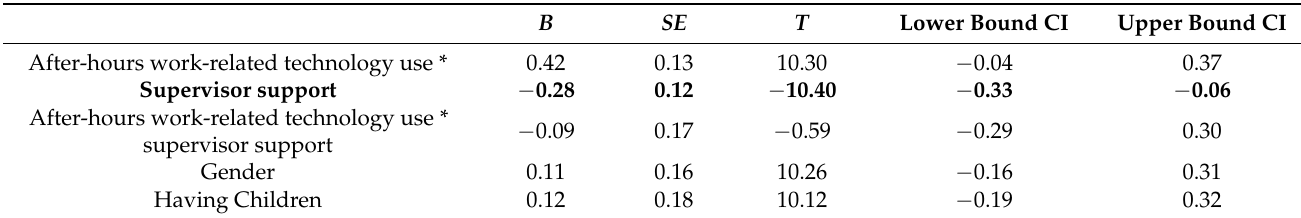
Table 3. Moderation Model results for supervisor support.